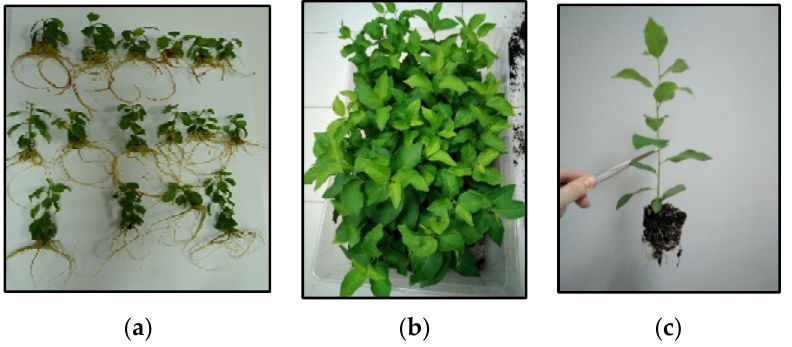
Figure 10. Shoots of CBP cultured in jars and RITA© with 3% sucrose and rooted in jars. ( a ) Shoots proliferated in jars 6 weeks after auxin treatment and ( b , c ) shoots proliferated in RITA© (6 immer- sions/day) 12 weeks after auxin treatment.